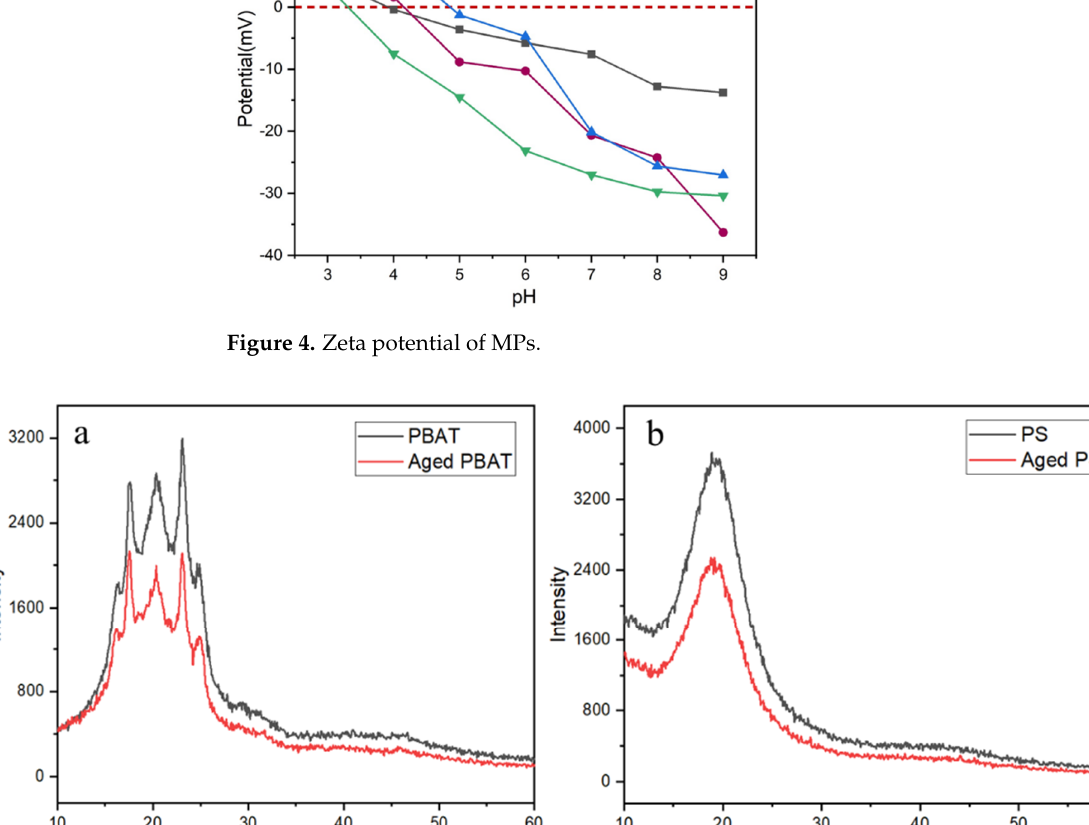
Figure 5. XRD spectra of PBAT and PS (( a ) PBAT, ( b ) PS).